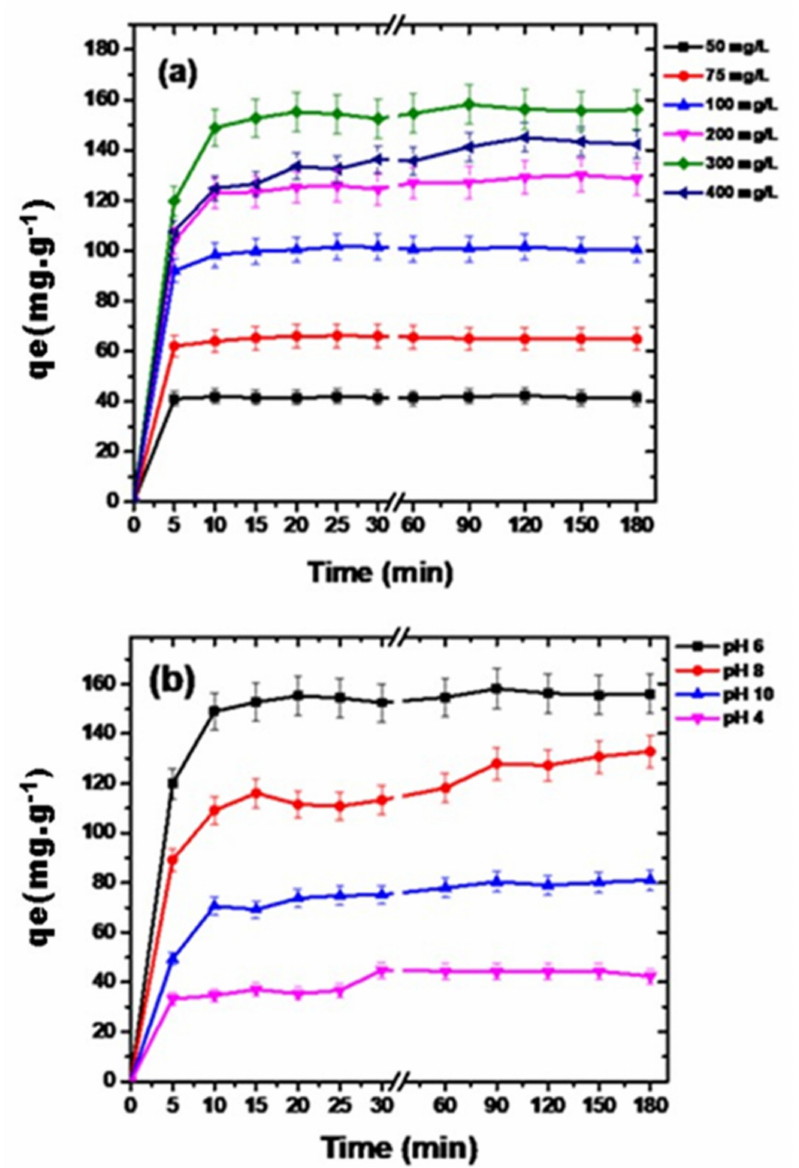
Figure 4. Variation in adsorption capacity of g-C 3 N 4 /MoO 3 (3%) over ( a ) changing concentrations of aqueous diclofenac; ( b ) solution